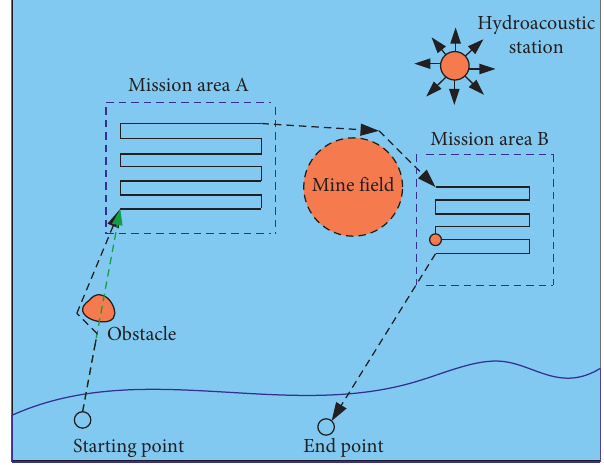
Figure 7: Task graph for unmanned underwater